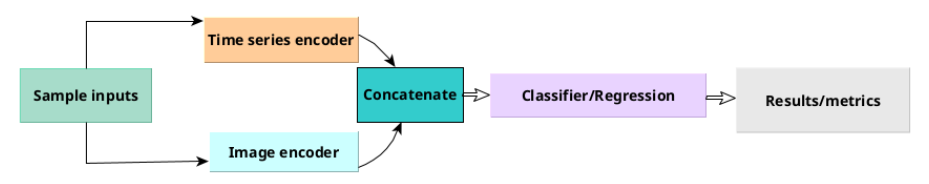
Figure 1. Simple multimodal machine learning analysis workflow